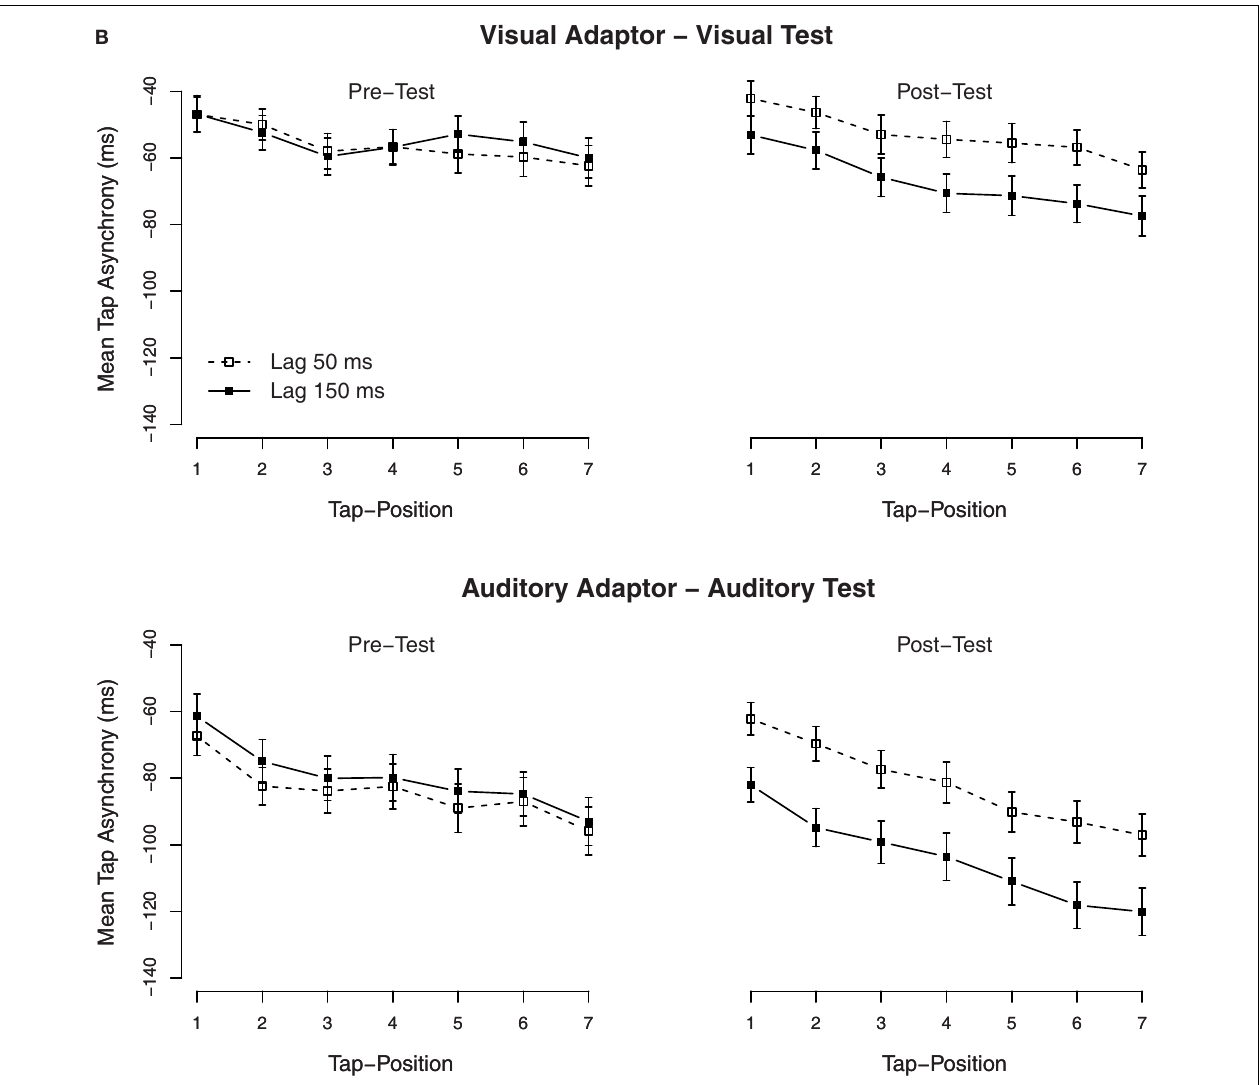
FIGURE 2 | Mean tap asynchronies in Experiment 1. (A) Mean tap asynchronies per trial block. One block contained three consecutive trials. (B) Mean tap asynchronies per tap in one trial. One trial contained seven